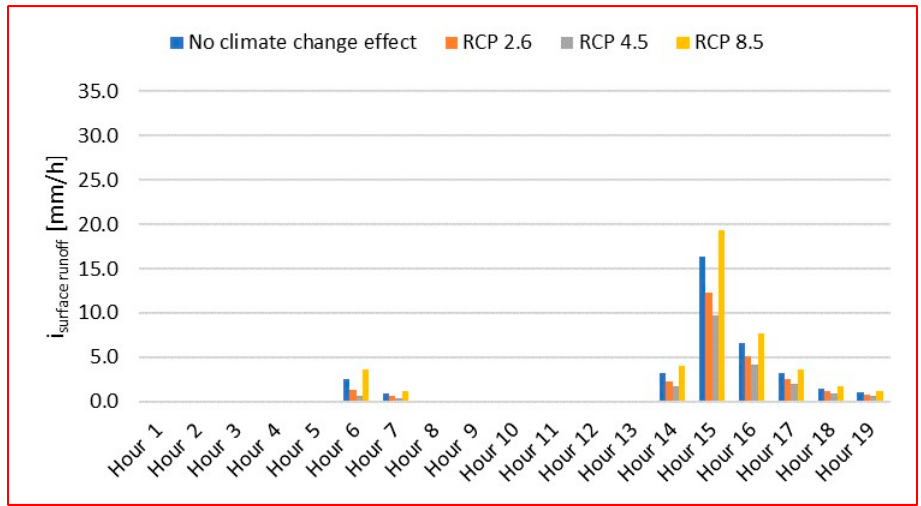
Figure 8. Hyetographs of surface runoff (created using AMC II) in Sarnico station (4 September 2011 rainfall event): hyetograph with no climate change effect is reported together with the projections in the future climate (RCP 2.6, RCP 4.5 and RCP 8.5).